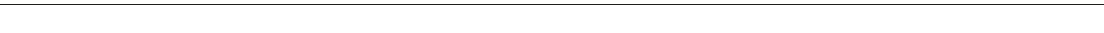
Fig. 7 GLIS1 overexpression favors brown adipocyte differentiation of satellite cells. a – d Control (Ctrl-mCh) and GLIS1 overexpressing (GLIS1-mCh) FACS- sorted satellite cells differentiated for 7 days in adipogenic medium. a ORO staining (1) and immuno fl uorescence assays using antibodies directed against: GFP (green), mCh (red), and Myh (white) (2), Ucp1 (green), mCh (red), and ORO (white) (3), or GFP (green), mCh (red), and ORO (white) (4). Nuclei were stained with DAPI (blue). Arrows indicate that GLIS1-mCh adipocytes express Ucp1 (3) and nGFP (4). b – d Signi fi cance was calculated by two-tailed Student ’ s t -test. b Quanti fi cation of ORO-positive adipocytes that originate from nGFP-expressing satellite cells per cm 2 . c Measurement of ORO fl uorescence intensity in nGFP-positive satellite cells displayed as percentage of Ctrl. d qRT-PCR analysis showing relative transcript levels of indicated genes. e ChIP-qPCR analyses using Glis1 antibody or rIgG control on Ctrl-GFP or GLIS1-GFP C2C12 and satellite cells differentiated for 1 day in adipogenic medium. Immunoprecipitated chromatin was quanti fi ed by qPCR analysis using primers for the promoter regions of Cebp α , Adipoq , and Ucp1 , or an unrelated control region. f , g Representative tibialis muscle sections from wild-type muscle injected with Ctrl-GFP or GLIS1-GFP adenovirus 0, 5, 7, and 14 days after Ctx treatment. f Gomori staining, and g immuno fl uorescence assays using antibodies directed against GFP (green), Plin1 (red), and Myh (white) or GFP (green), Ucp1 (red), and Myh (white) as indicated. Nuclei were stained with DAPI (blue). Arrows indicate that adipocytes express GFP ( b , c : n = 6, d , e : n = 4; mean + SEM, * p < 0.05, ** p < 0.01, *** p < 0.001; scale bars: a (1), g 50 µ m, a (2-4), f 100 µ